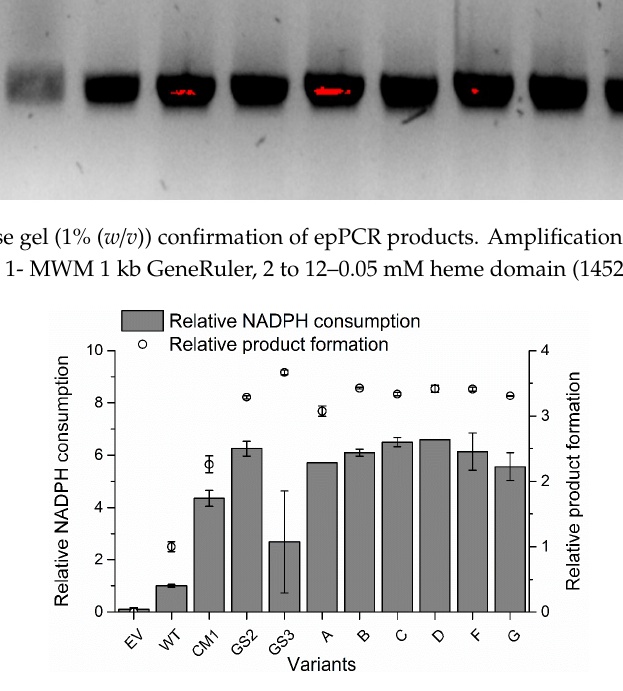
Figure A7. Comparison between P450 BM3 WT and resulting variants from the 2 rounds of epPCR of NADPH consumption rate (bars) and product formation (circles) using a 4-AAP assay. Error bars represent one SD of the mean from three replicates. CM1 (R255P/P329H), GS2 (R255S/P329H/F331L), and GS3 (I122V/ R255S/P329H/F331L).